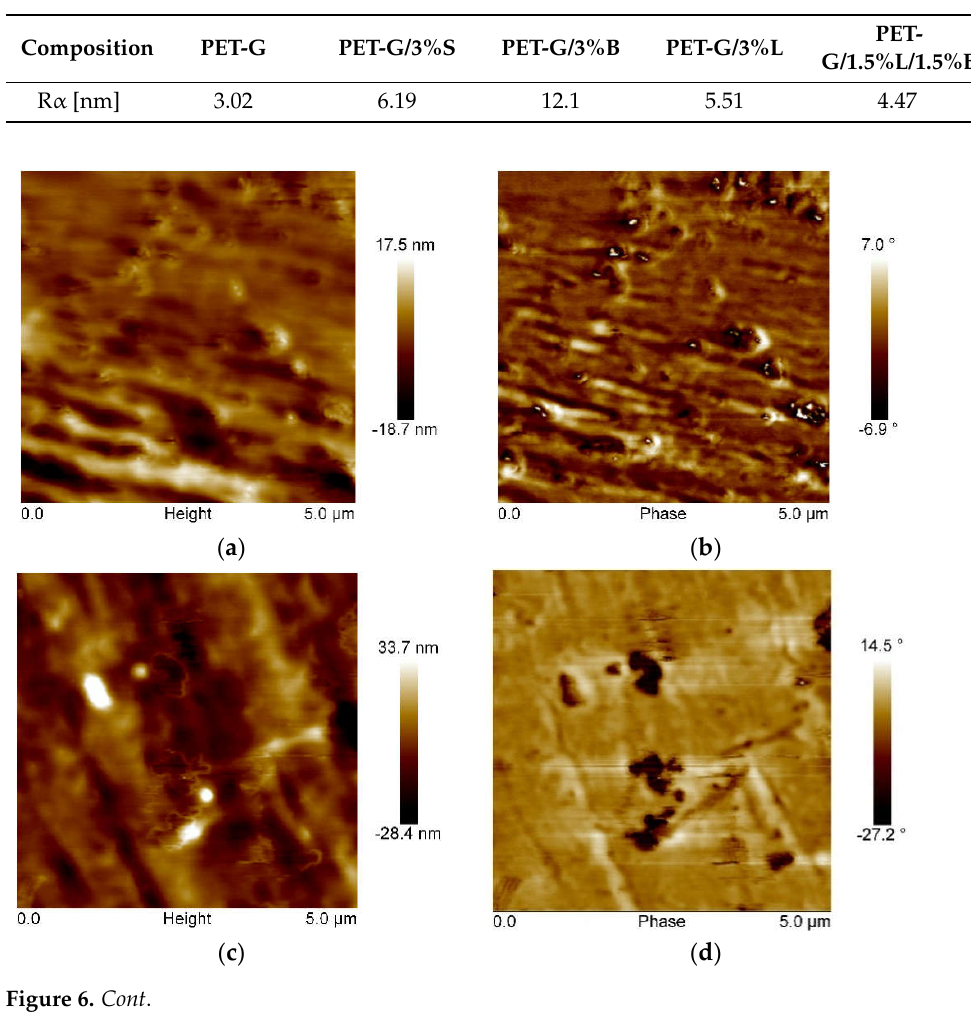
Table 5. Summary of the obtained MFR results.